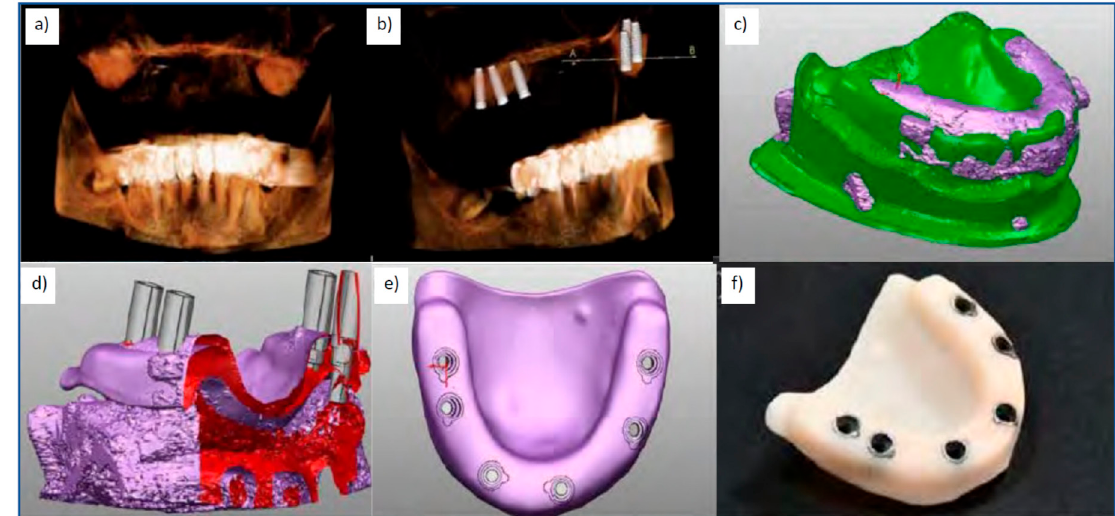
Figure 34. The procedure for making the template for implantation of six implants; ( a ) a 3-D model created based on CBCT; ( b ) planed the placement of implants; ( c ) the ready bone base model folded together with the intraoral model using an individual positioning plate; ( d , e ) two views of a model of the drill guide tubes; ( f ) the ready template plate using the 3-DP SLA technology.